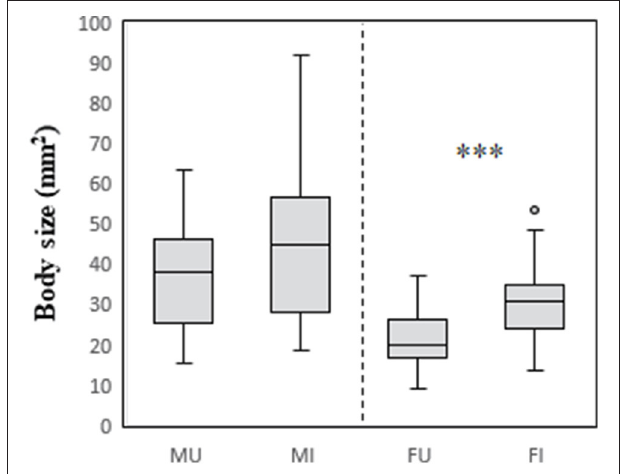
FIGURE 1 | Relationship between body size, host sex, and infection status in C. intermedius . Body size measures (surface area, mm 2 ) were obtained from digital images of the dorsal surface of the body. M, male; F, female; U, uninfected; I, infected. ***Indicates P < 0.001.